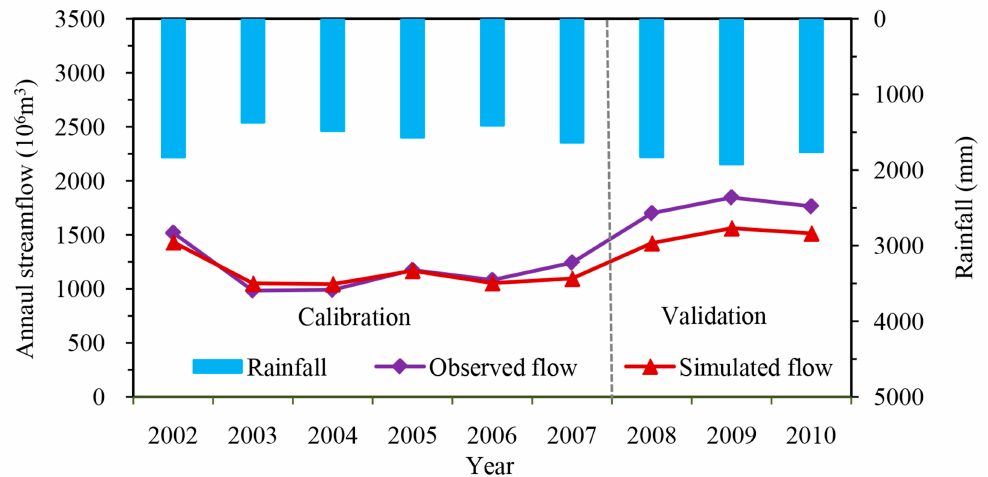
Figure 2. Comparison of simulated and observed annual streamflow in the Xitiaoxi watershed during the calibration and validation period.